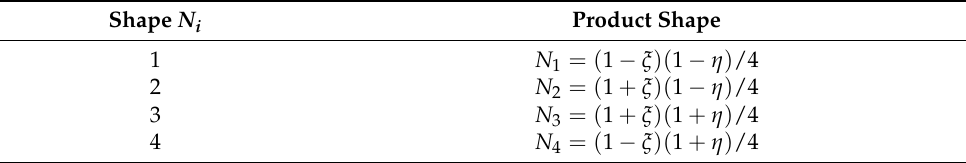
Table 2. Integral form of shape functions